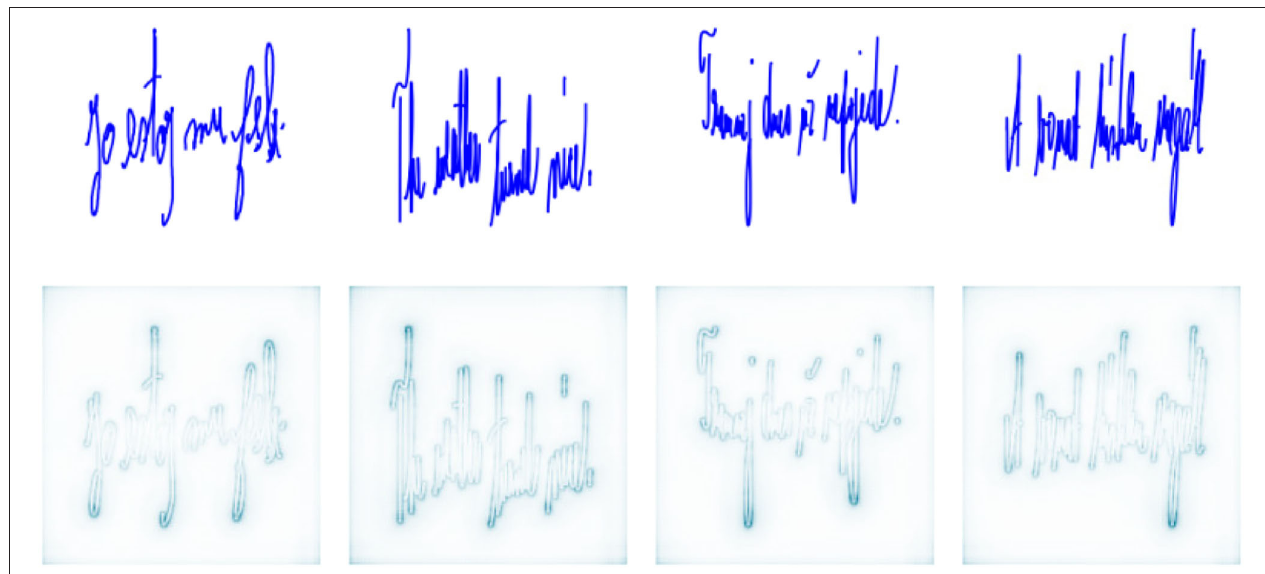
FIGURE 5 | Relevance maps for four sentences (one random sample is depicted for each language).